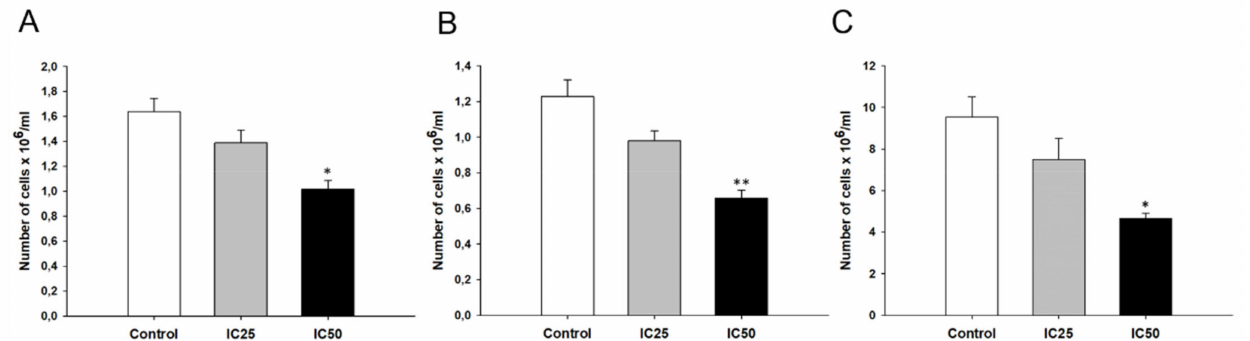
Figure 13. Cells proliferation after piperine treatment in W1PR1 ( A ), W1PR2 ( B ), and W1TR ( C ) cell lines. For each cell line the control is shown, and results obtained for piperine IC25 and IC50 concentrations. Bars represent the mean number of cells after 72 h incubation ± SD values. * p < 0.05; ** p < 0.01; * Represents the comparison with the control